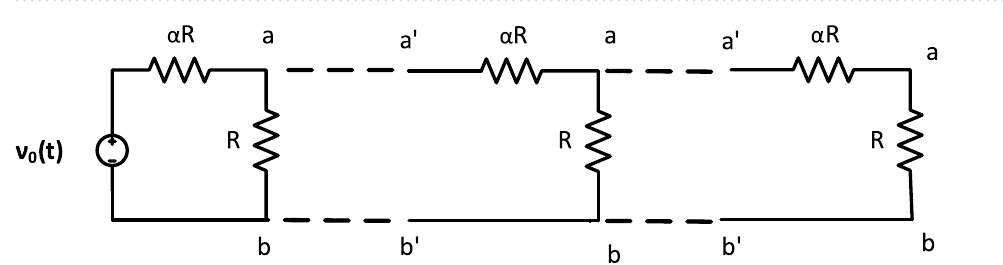
Figure 2. An cTAM ladder circuit is assembled as ladder tiles attach to a seed with a DC voltage source ν 0 and subsequently, each other as long as the voltage across the resistor R at the terminus is at least τ . In addition, Watson–Crick complementary DNA glues at the top ( a – a ′ ) and bottom ( b – b ′ ) bind the assembly